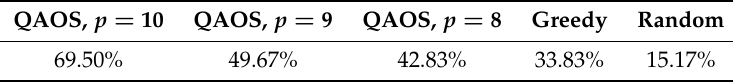
Figure 3. Performance evaluation results. G ( η ) is the cumulative distribution function (CDF) of η . Table 1. Percentage of optimal solution